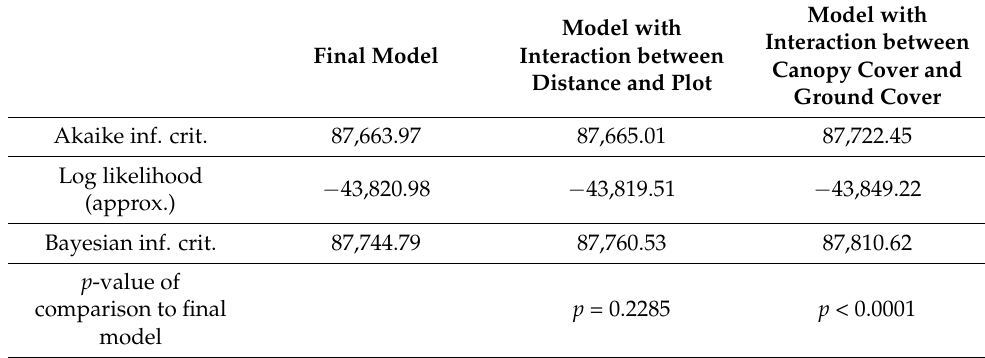
Table 4. Summary of the model results regarding the interaction between covariates. Model with Model with Interaction between Final Model Interaction between Canopy Cover and Distance and Plot Ground Cover Akaike inf. crit. 87,663.97 87,665.01 87,722.45 Log likelihood 43,820.98 43,819.51 43,849.22 (approx.) − − − Bayesian inf. crit. 87,744.79 87,760.53 87,810.62 p -value of comparison to final p = model